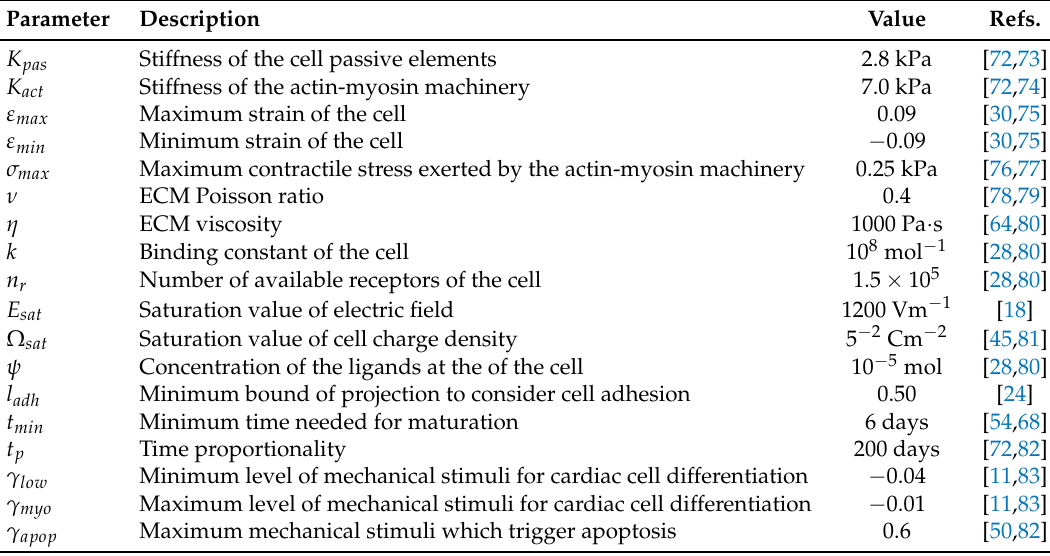
Table 1. Mechanical parameters considered in the